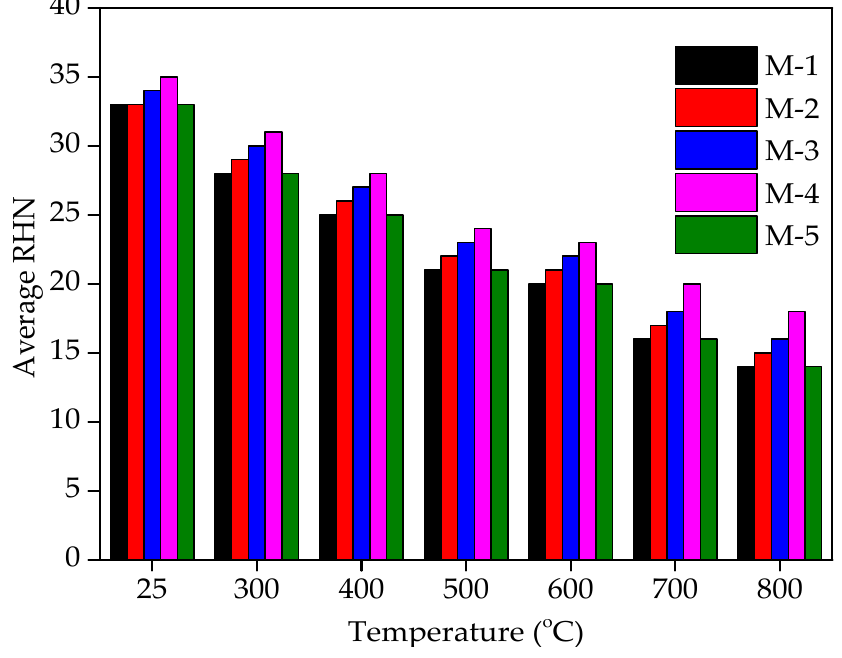
Figure 11. RHN values of WFS concrete at different temperature levels.